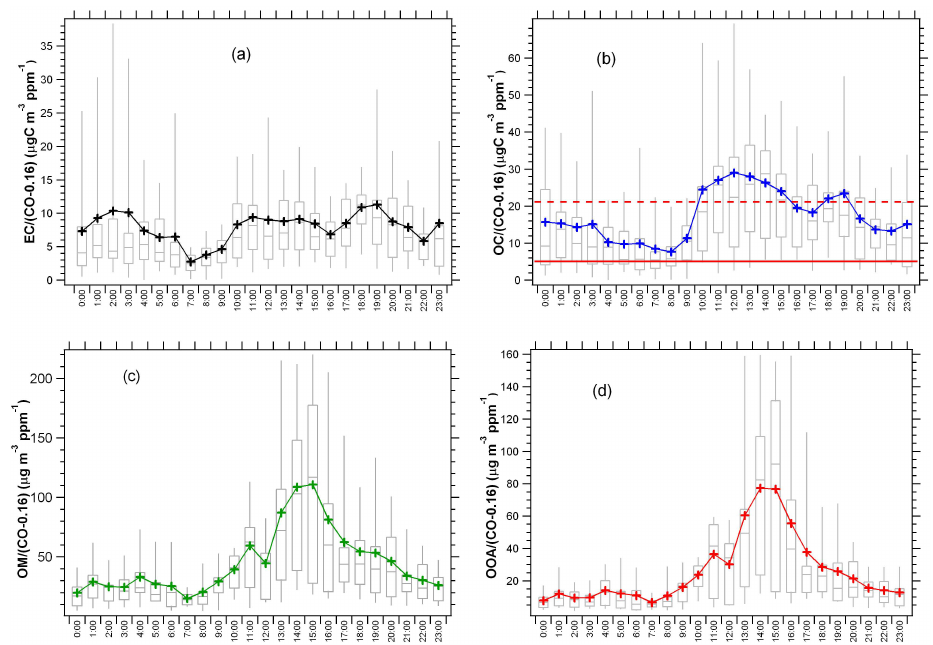
Fig. 6. Diurnal variations of different aerosol species EC (a) , OC (b) , OM (c) , OOA (d) versus (CO-0.16). The value of 0.16ppm was CO background concentration. The box plot is the same meaning as Fig. 5 showed. The red lines in Fig. 6b indicate estimates for the direct emissions (solid) and secondary formation after half a day of processing (dotted) of organic aerosol in the northeastern US (de Gouw et al.,